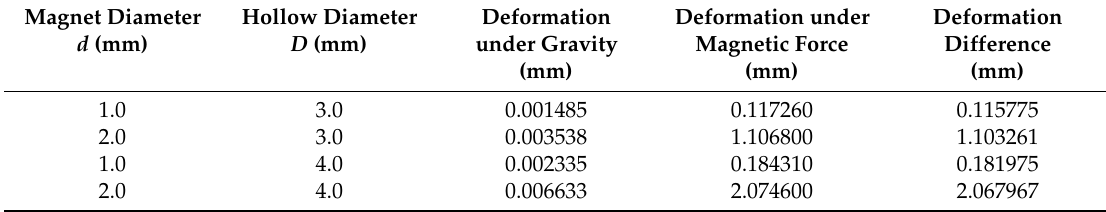
Figure 3. Simulated deformation of Ecoflex membrane caused by a permanent magnet (magnet diameter d = 2 mm, hollow diameter D = 4 mm). Table 1. Results of simulated deformation of Ecoflex membrane caused by a permanent magnet.